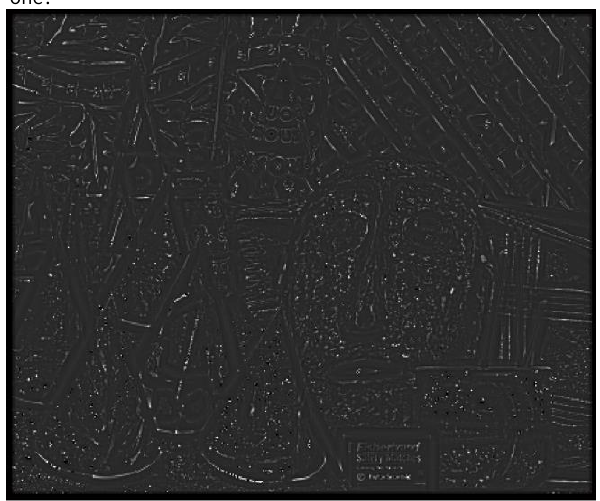
Figure 6. λ in different areas of